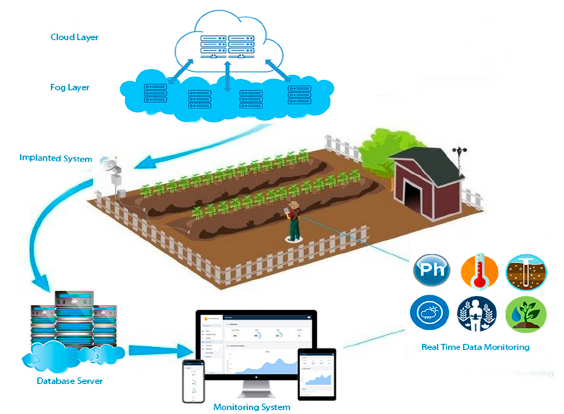
Figure 2. System Design and